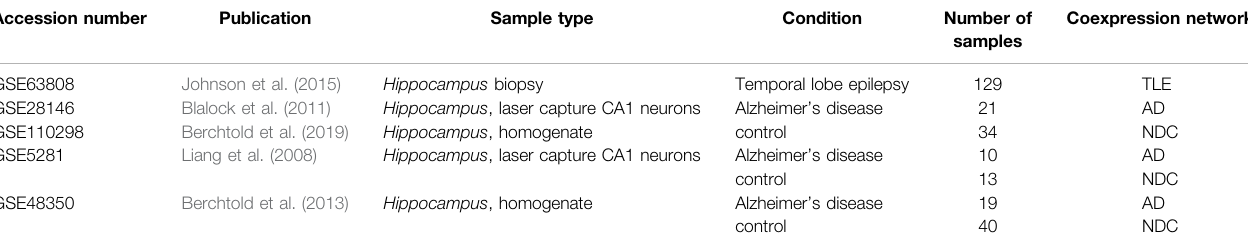
TABLE 1 | List of the datasets used for this analysis. All raw microarray datasets were downloaded from NCBI Gene Expression Omnibus using the GEOquery R